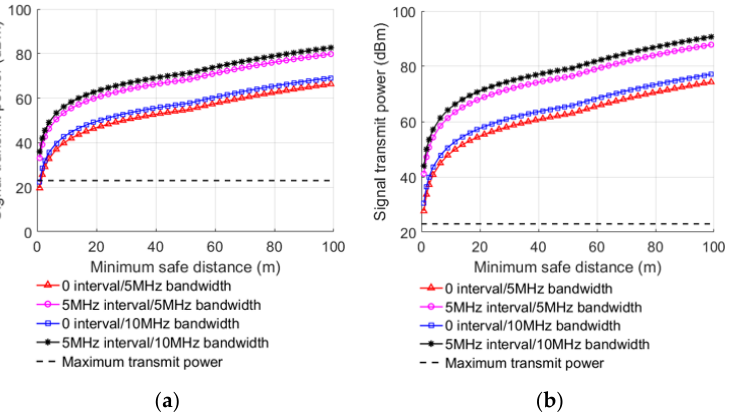
Table 5. LTE FDD UE interfering with LTE-M TE.